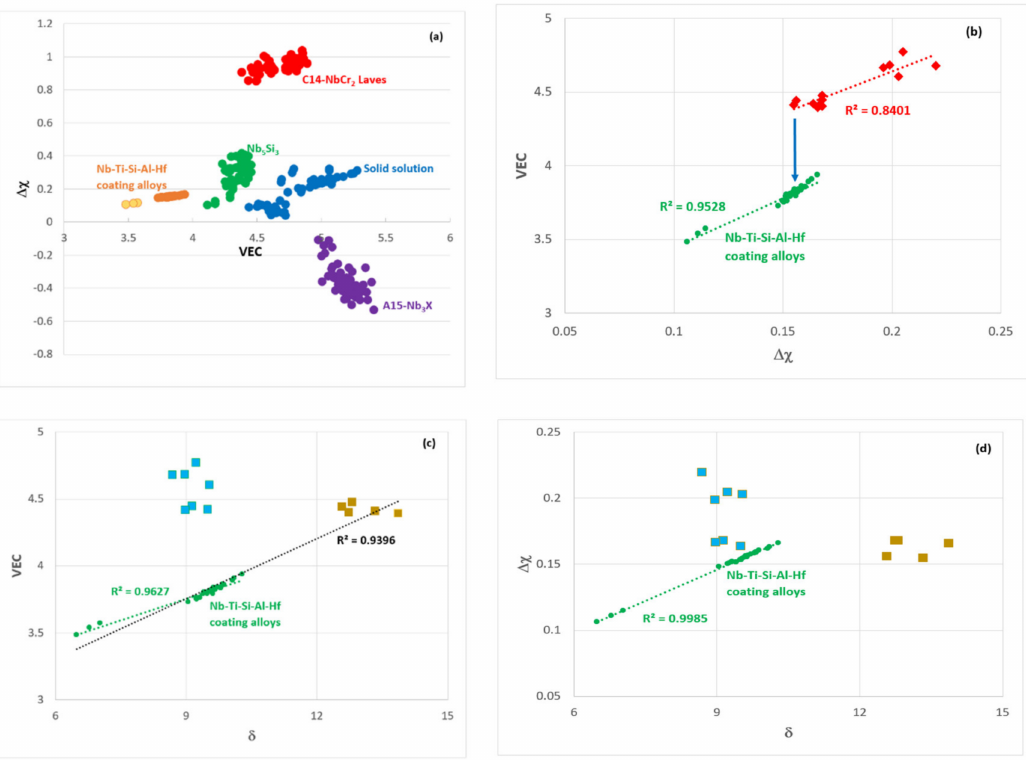
Figure 12. ( a ) VEC versus ∆ χ map of phases in Nb-silicide based alloys [27] showing the location of Nb-Ti-Si-Al-Hf coating alloys. For non-pesting alloys [54] and Nb-Ti-Si-Al-Hf coating alloys ( b ) VEC versus ∆ χ map, ( c ) VEC versus δ map and ( d ) ∆ χ versus δ map. In (c) and (d) gold colour for B containing alloys, blue colour for Sn and/or Ge containing alloys, in (b) red colour for B, Sn and Ge containing alloys. In (a) light orange colour is for zone A in layered coating alloys